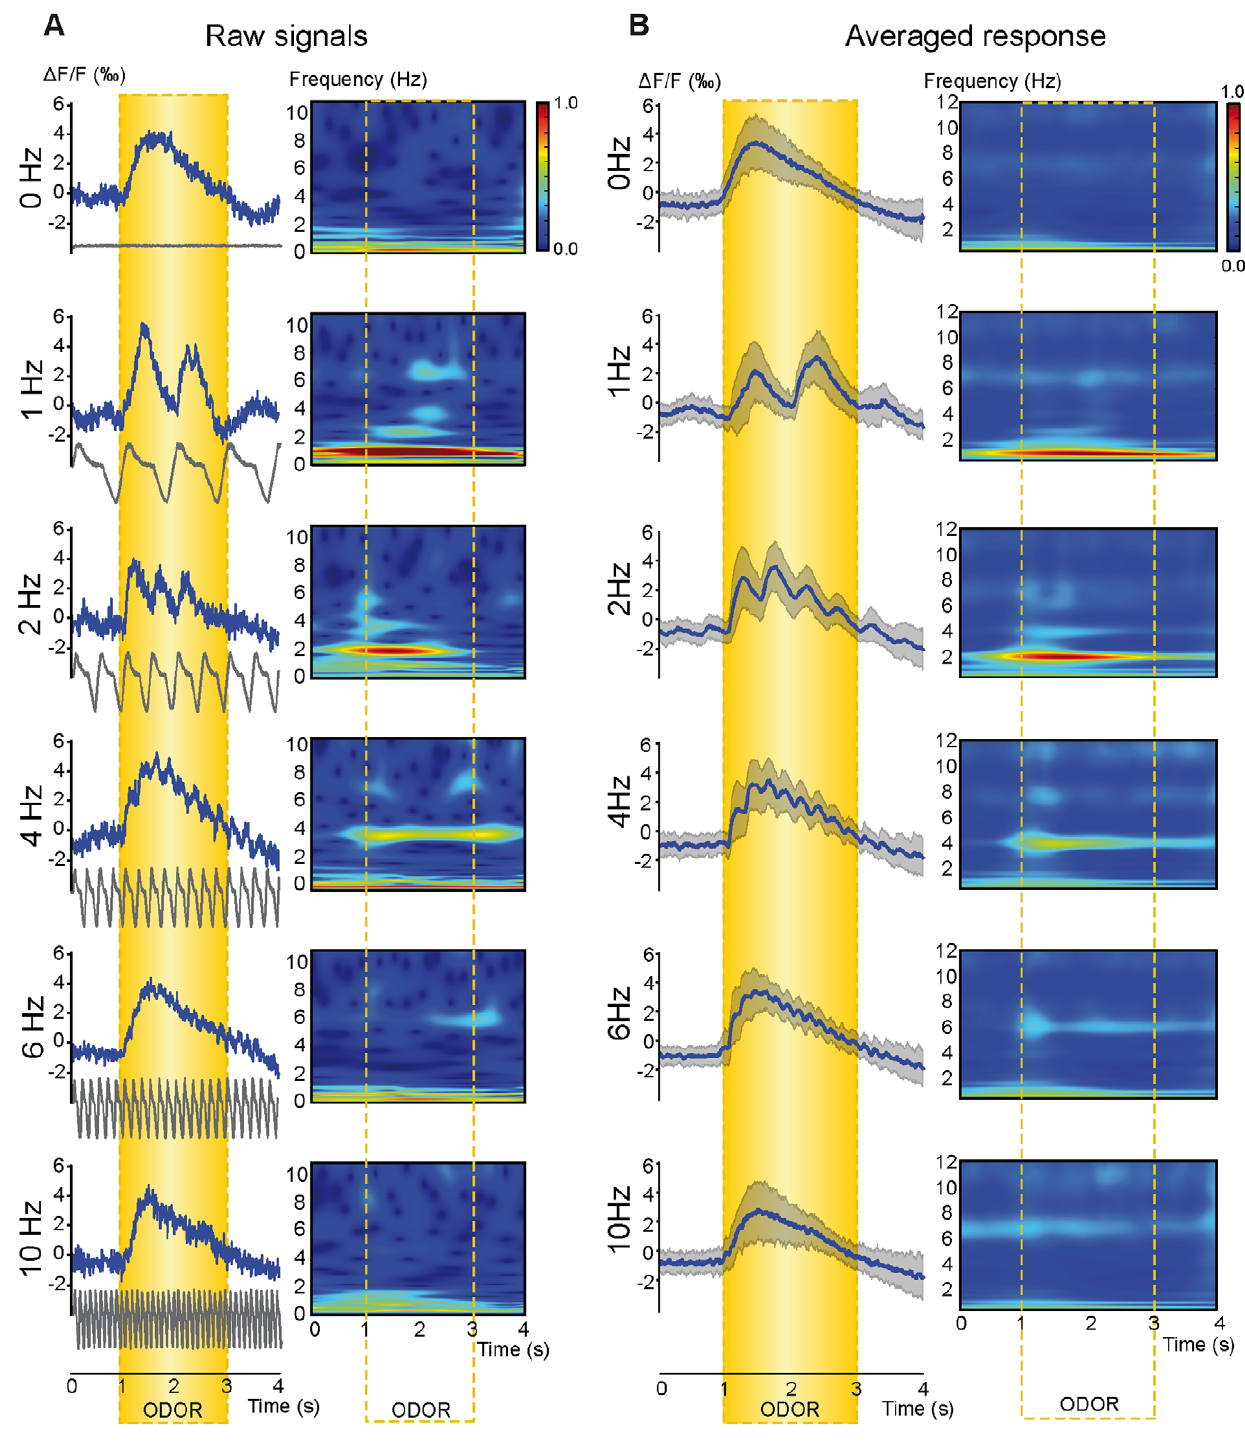
Figure 2. Impact of sniffing frequency on VSDi signal dynamics. A: An example of a raw VSDi signal time-course (left) computed from the activated areas (see Fig. 1 and material and methods) and corresponding time-frequency representations (right). The black traces at the bottom of each panel represent the imposed sniffing signal recorded at the nostril entrance. Each line corresponds with a different sniffing frequency. Responses were recorded using a 1000 ml/min flow rate. The color scale (arbitrary unit) was the same for all time-frequency representations. B: Averaged optical responses (blue line) 6 SD (shadow area) computed from all animals according to the different sniffing frequencies (left), regardless of flow rate (0 Hz, n=59; 1 Hz, n=65; 2 Hz, n=151; 4 Hz, n=123; 6 Hz, n=75; 10 Hz, n=63). The corresponding mean time-frequency representation (right) computed from all individual time-frequency representations. The color scale (arbitrary unit) was the same for all time- frequency representations. Yellow box indicates odor stimulation period.